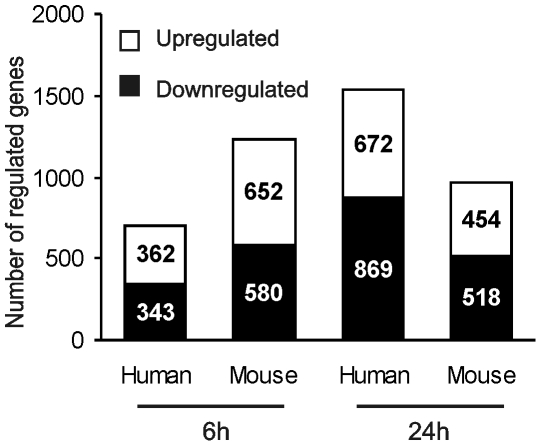
Wy14643 treatment causes major changes in gene expression in human and mouse hepatocytes.Bars show number of up- and down-regulated genes in primary human and mouse hepatocytes treated with Wy14643 for 6 h or 24 h. Genes were considered significantly regulated if mean fold change (MFC)>1.1 and P<0.05.